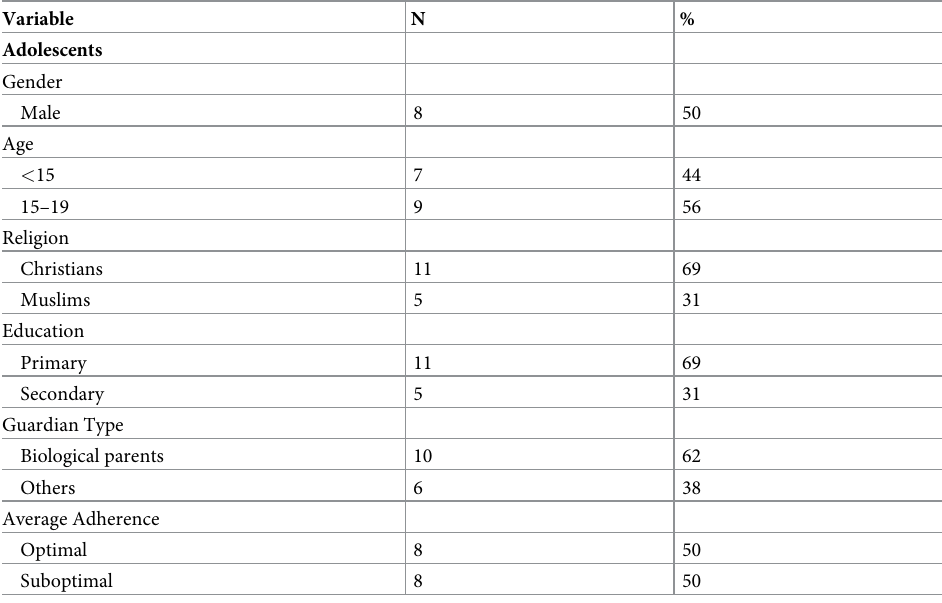
Table 2. Demographic profile of participants who were